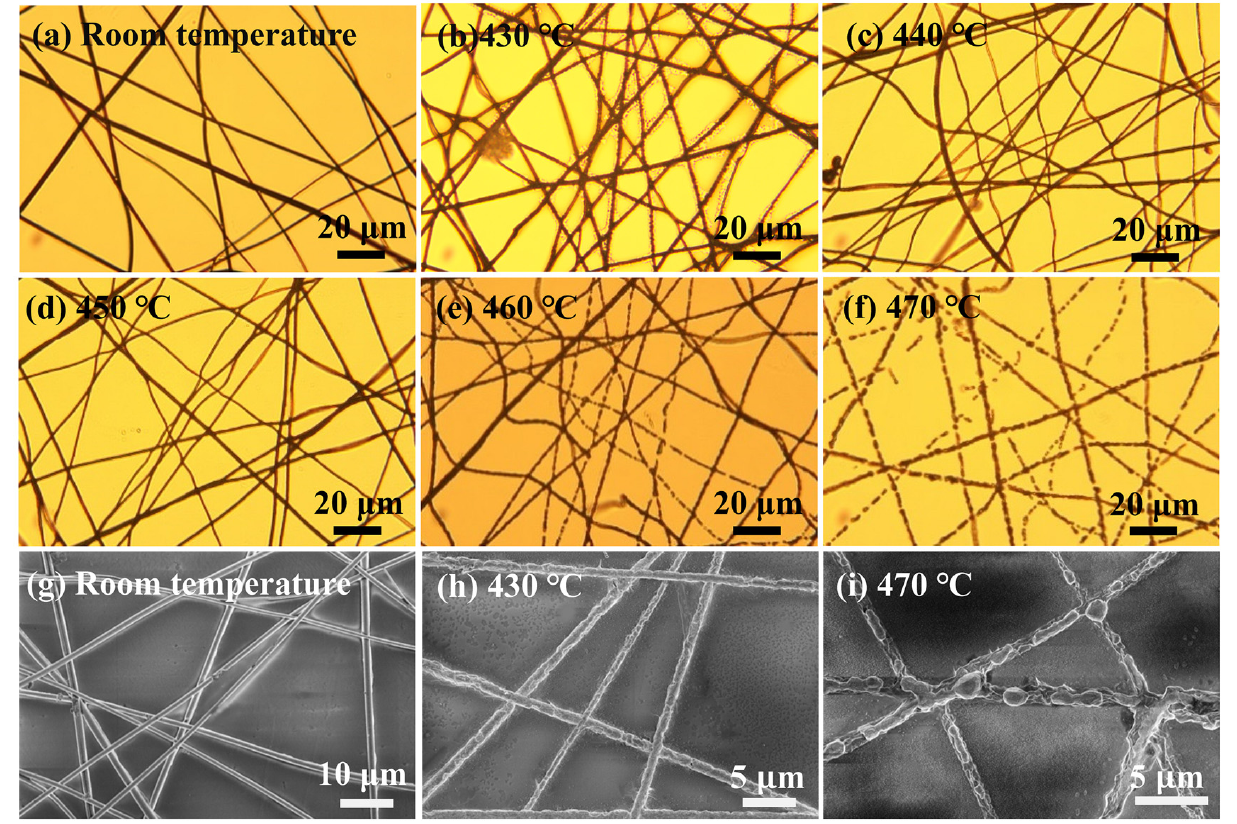
Figure 6. ( a – f ) The micrograph of melting state of W/AgNWs at different temperatures. ( g – i ) The SEM images of melting state of W/AgNWs at different temperatures.